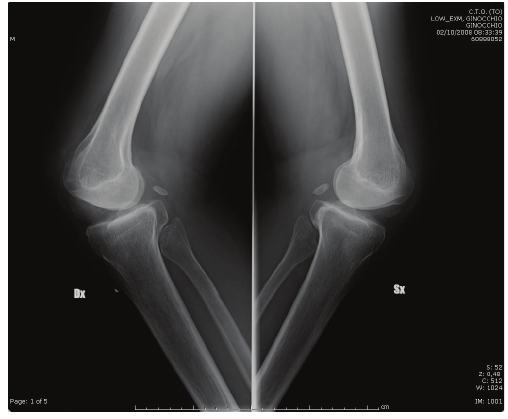
Figure 4: Lateral roentgenograms of the knees at about 30 degrees of flexion, showing dislocated patellae, marked lateral rotation deformities of the tibiae, and condylar deformity.